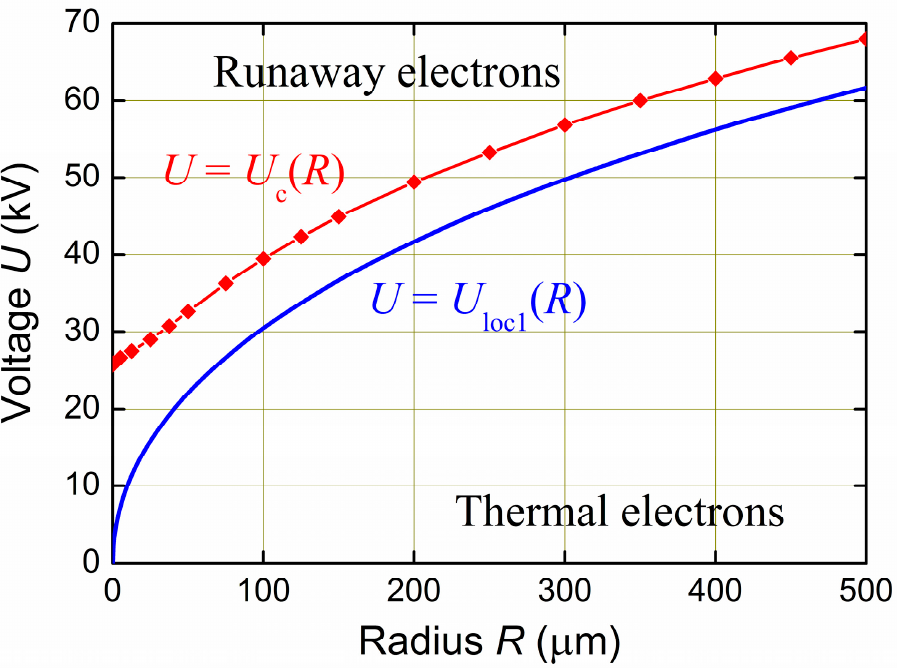
Figure 6. The numerically calculated dependence of the threshold voltage U c on the cathode edge radius R (red diamonds) is shown. For comparison, the R -dependence of the threshold voltage U loc1 corresponding to the classical local criterion E 0 > E c is given (blue line). Gap width 7.5 mm; the gas is atmospheric air.